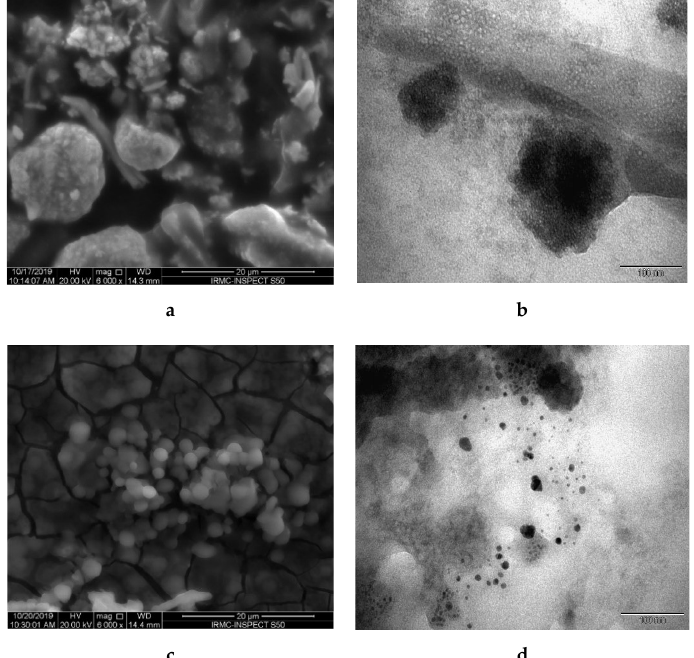
Figure 5. Morphological study of Ag and TiO 2 NPs—( a ) scanning electron microscopy (SEM) and ( b ) transmission electron microscope (TEM) images of TiO 2 NPs; ( c ) SEM and ( d ) TEM images of Ag